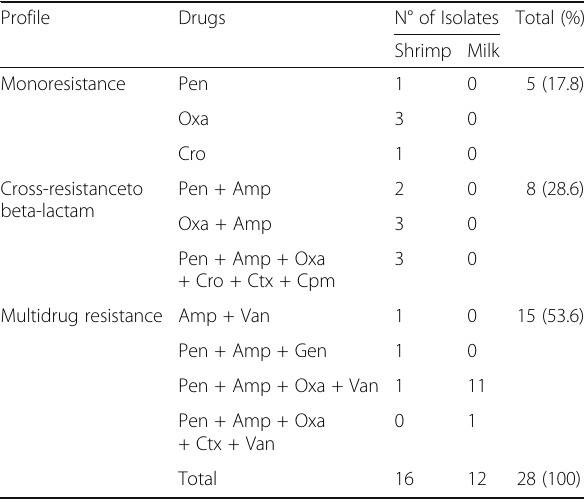
Table 1 Antimicrobial resistance profile of 28 Stapylococcus aureus strains isolated from milk and shrimp